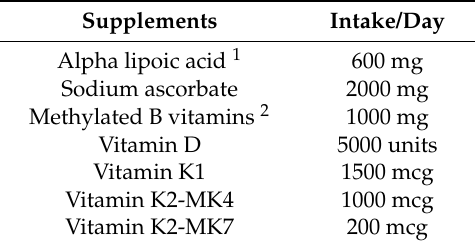
Table 2. Supplementary medication taken concurrently with IV vitamin C infusion by